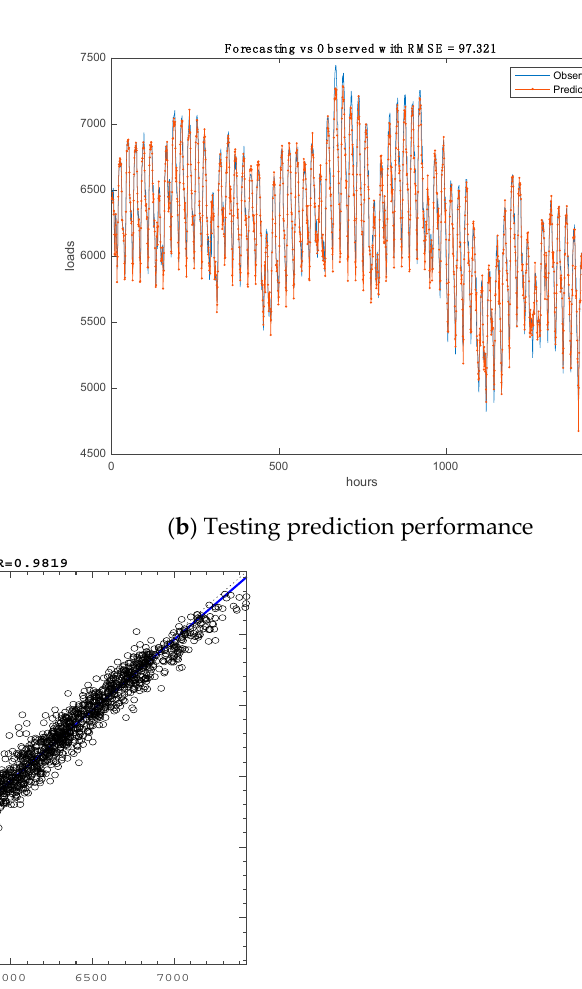
Figure 11. Hybrid CNN–GRU model prediction performance for the Jeddah load: ( a ) training and testing, ( b ) testing, and ( c ) regression plot.